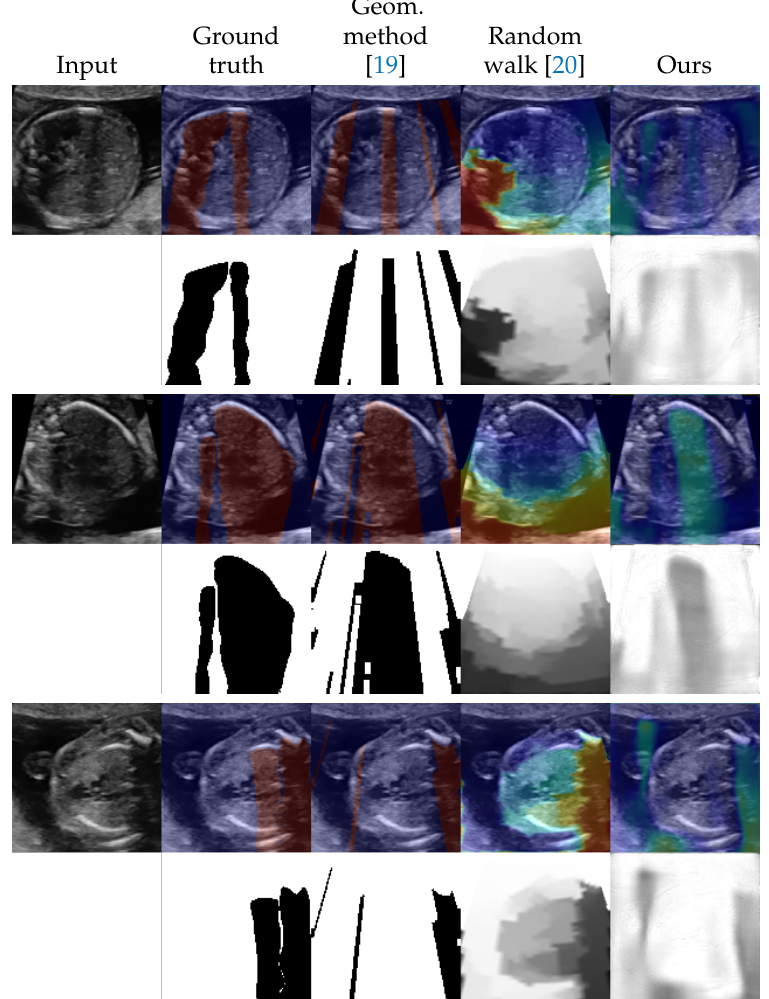
Figure 2. Examples of shadow detection results for the methods that do not use labels. The lower side of each example shows detection results, and the upper side shows them overlayed to the input image. For overlayed images, blue corresponds to low intensities and red corresponds to high